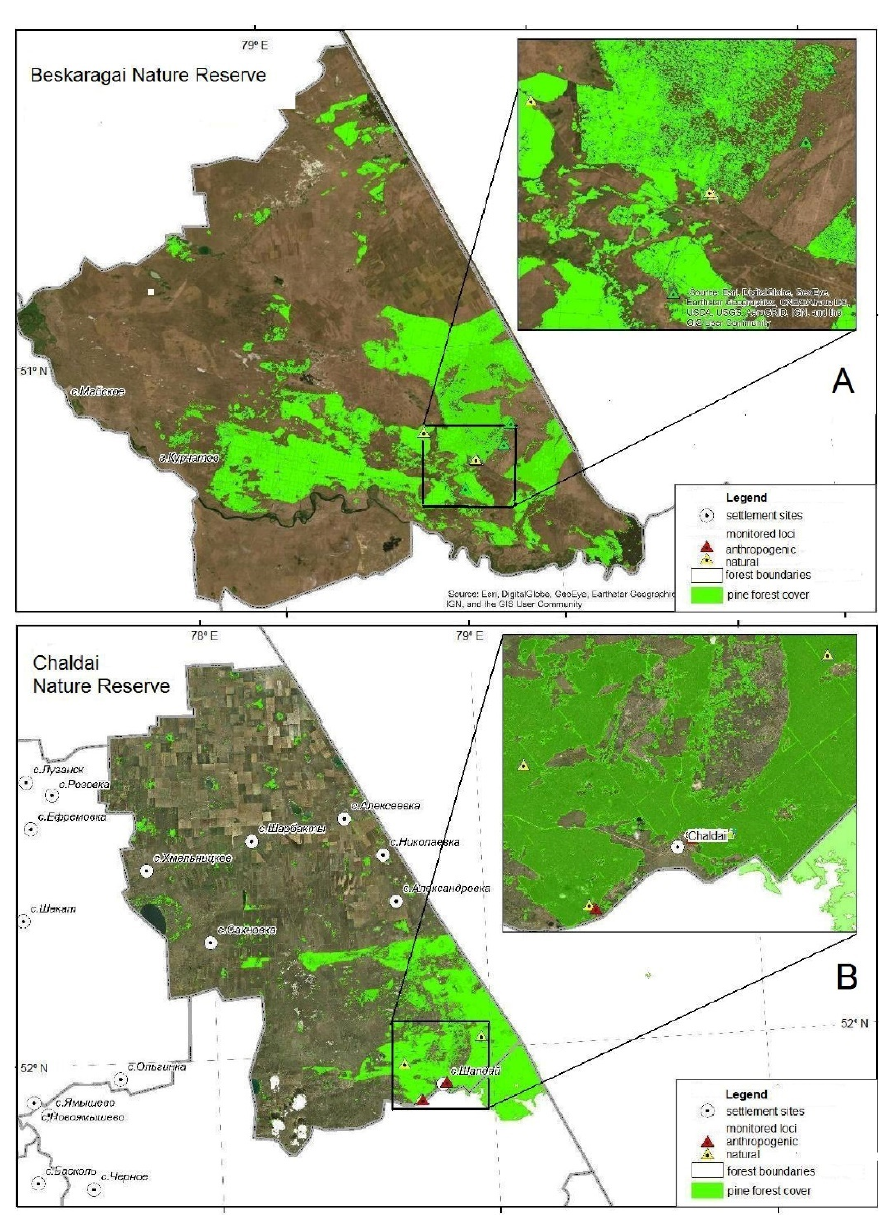
Figure 2. GIS vegetation cover projection of the distribution of the pine forests in the Beskaragai ( A ) and Chaldai ( B ) Nature Reserves.